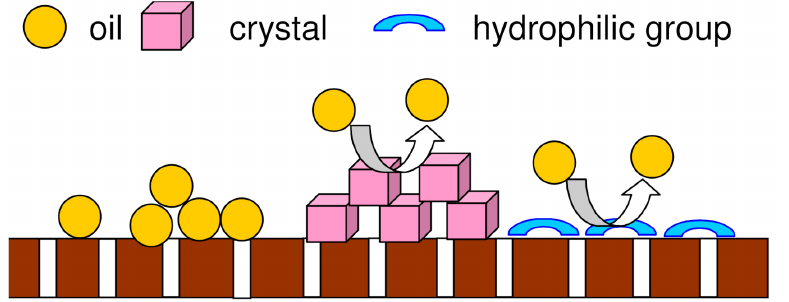
Figure 4. Impact of scaling phenomenon on the oil adsorption on the hydrophobic membrane